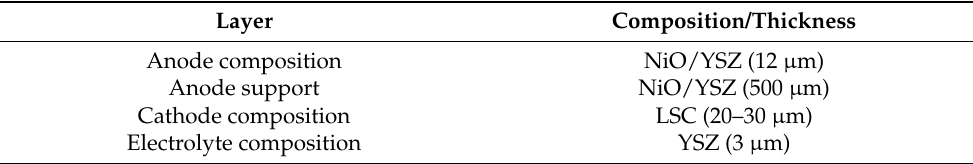
Table 1. Main composition and thickness of the commercial SOFC